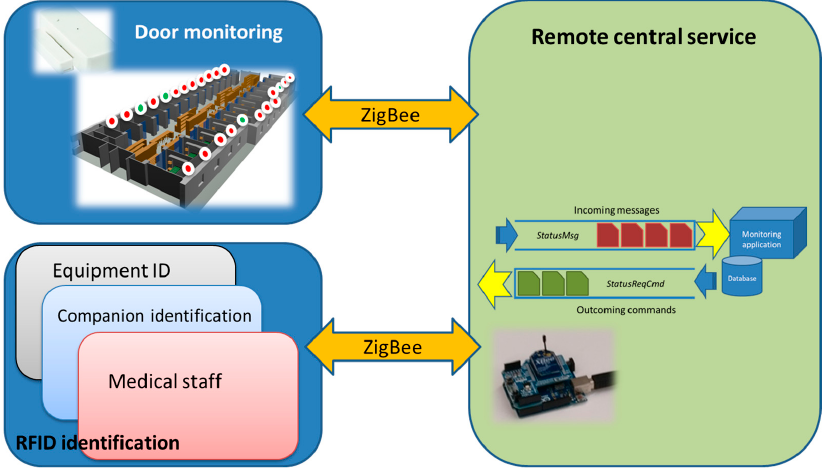
Figure 18. System architecture schema.